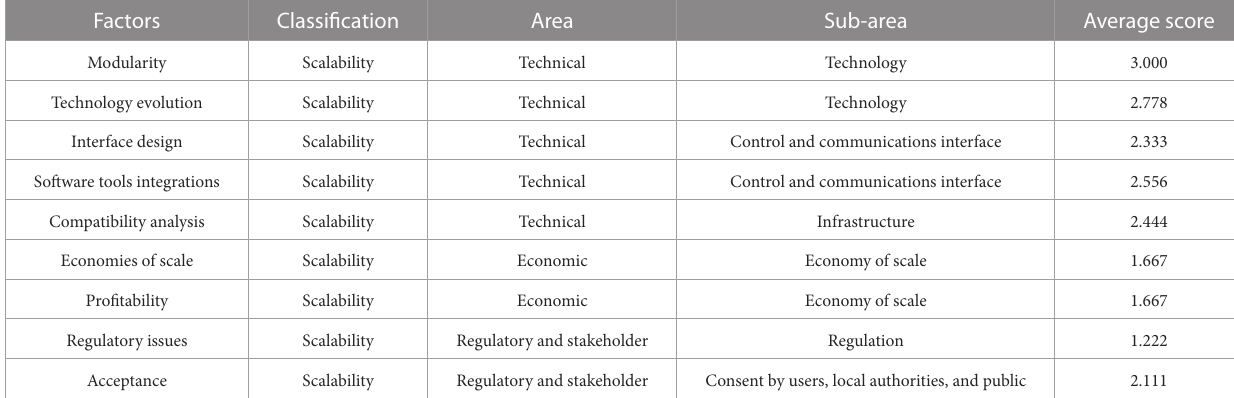
TABLE2 AveragescoreofeachscalabilityfactorinCROSSBOWproducts.